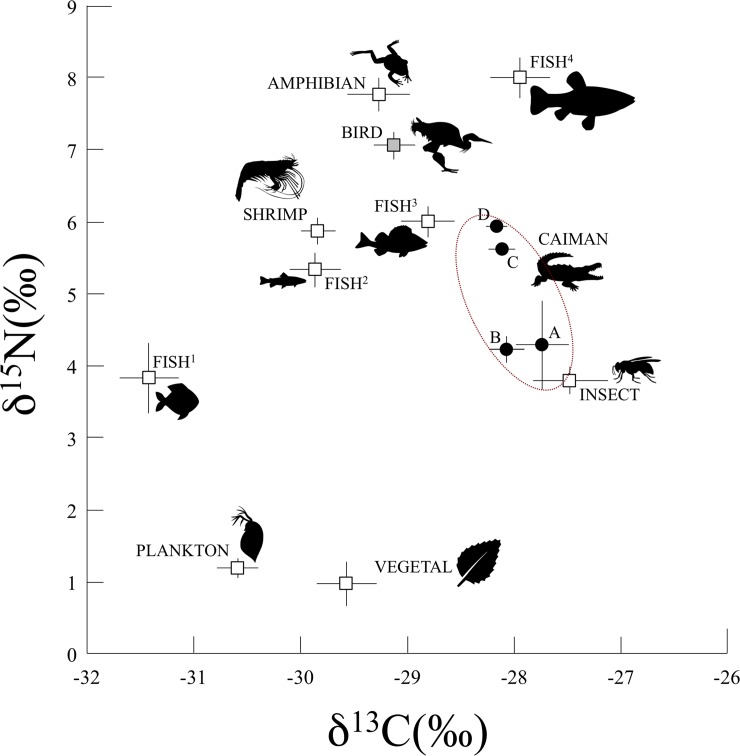
Mean (± SE) δ15N and δ13C values for the black caimans and the different ecosystem compartments of Agami Pond.The symbols represent each ecosystem compartment. The black circles are the black caimans belonging to different age classes (A, B, C, D); the white squares are the different ecosystem compartments during the wet and dry seasons; and the gray square is the bird compartment (only present during the wet season).